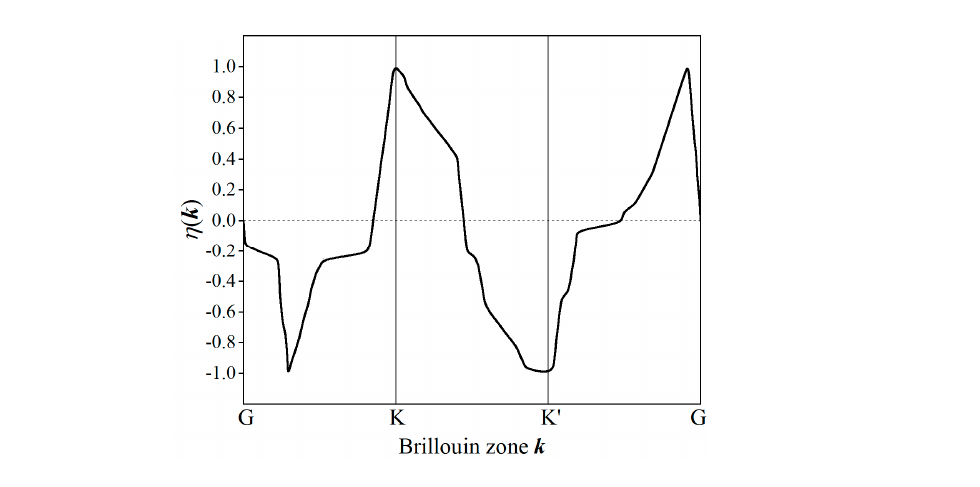
Figure 6. Valley polarization of HBi 2 OH monolayer along high-symmetry path through valley K and K ′ points.